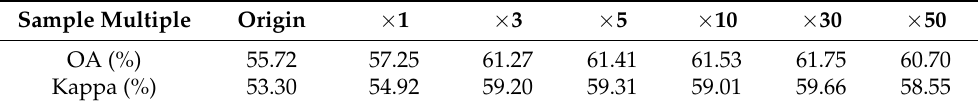
Table 6. Classification results of the different sample